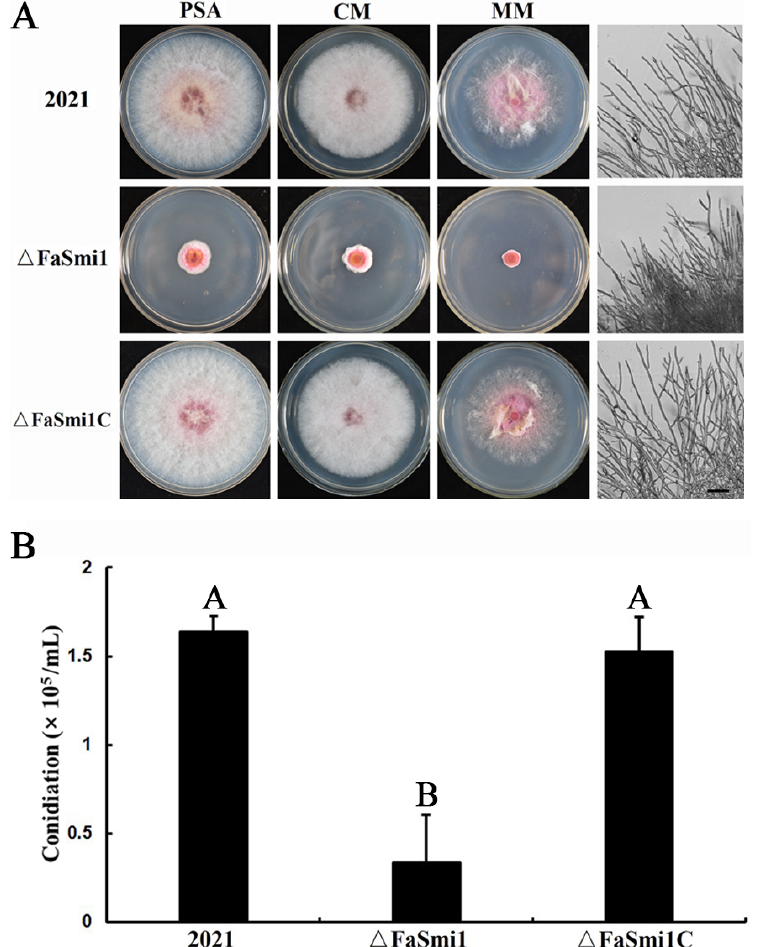
Figure 1. Deletion of FaSmi1 effect on mycelial growth and conidiation. ( A ) The colony microscopic assay of 2021, ∆ FaSmi1 and ∆ FaSmi1C was photographed after incubation on PDA, MM and CM for 3 days. Bar = 12 µ m. ( B ) Mycelial plugs of 2021, ∆ FaSmi1 and ∆ FaSmi1C were grown on MBB at 25 ◦ C for 7 days; the conidiation of each strain were measured. Bars denote standard errors from three experiments. Values on the bars followed by the same letter are not significantly different at p = 0.05.